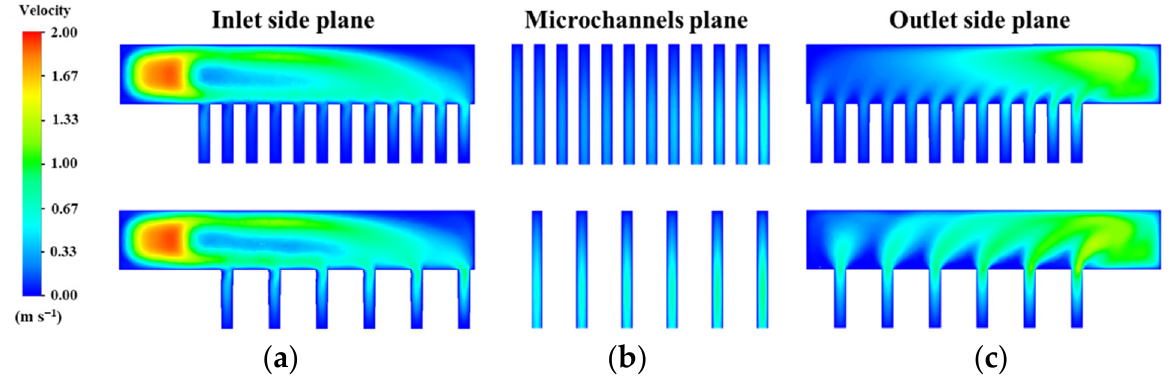
Figure 4. The fluid velocity distribution between MMC and MMDC structures. ( a ) Inlet side plane; ( b ) microchannels plane; ( c ) outlet side plane.